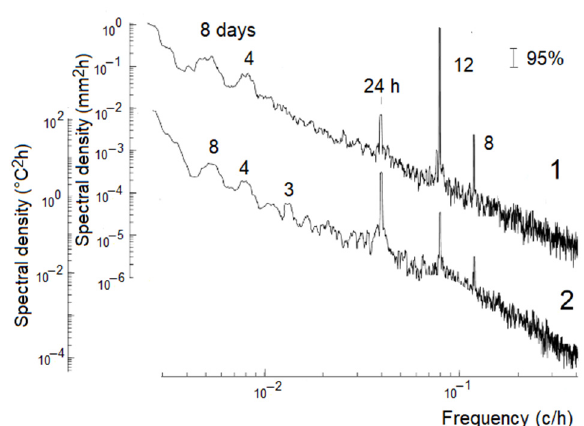
Figure 10. Spectra of lake level fluctuations (1) and temperature fluctuations (2) in bottom sediments in 2018–2019 in the area of the floating weather station (see Figure 2). The vertical line in Figure 10 shows the 95% confidence interval.